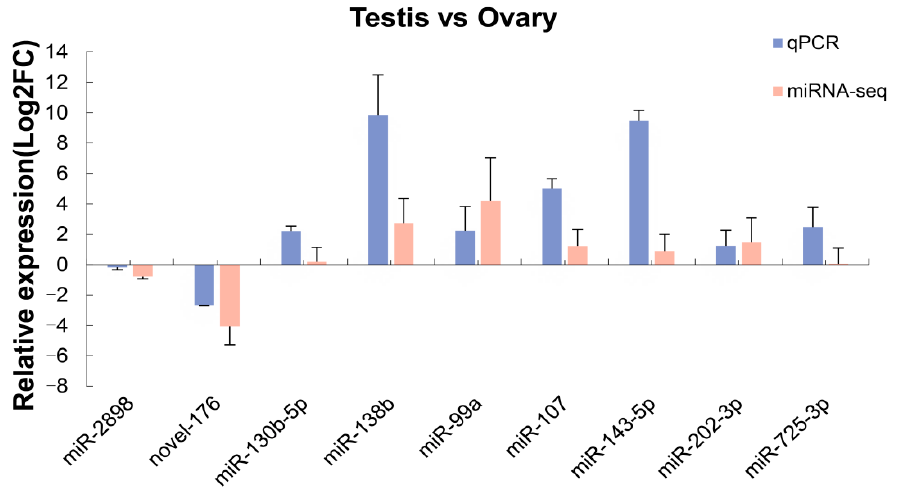
Figure 7. Comparison of the expression levels of nine DEMs by miRNA-seq and quantitative real-time PCR.